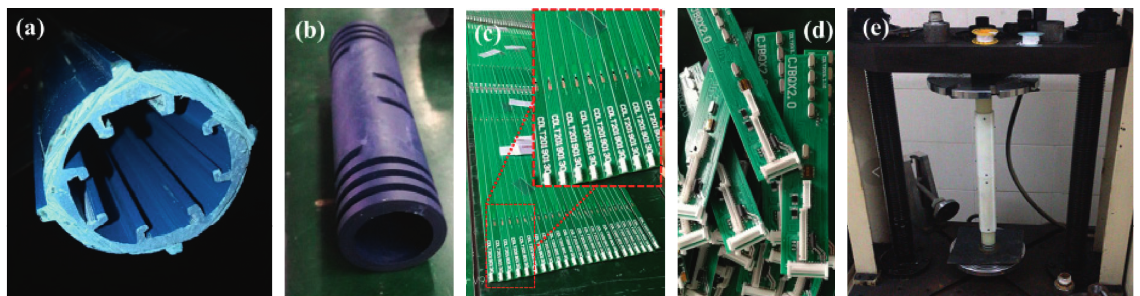
Figure 2: Photographs of (a) the cross section of the inner pipes, (b) PCBs with strain gauges, (c) PCBs with Wheatstone bridges, (d) waterproof connector, and (e) waterproof